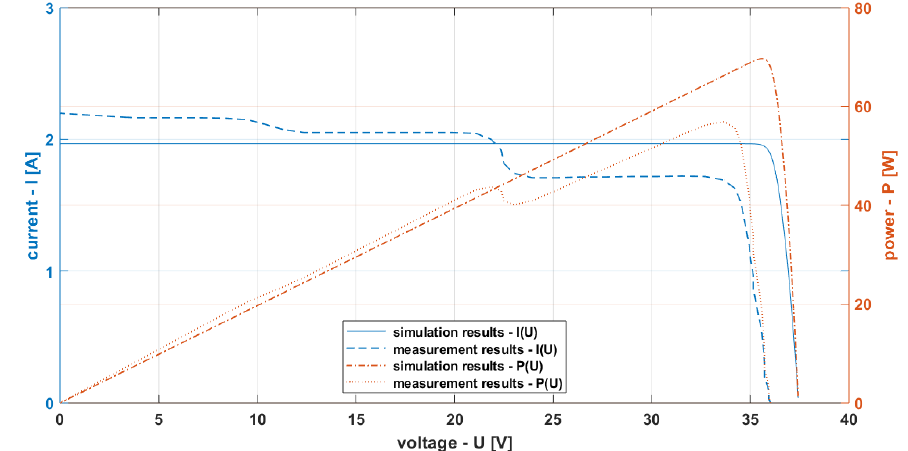
Figure 11. I–V characteristics of PV module MonoSol 260 EX made with partial shading. For detailed comparison of measurement and simulation results, see Table 2. Marking of measurement point M3 (six PV cells were shaded; the exact measurement time was 11:41 a.m.).